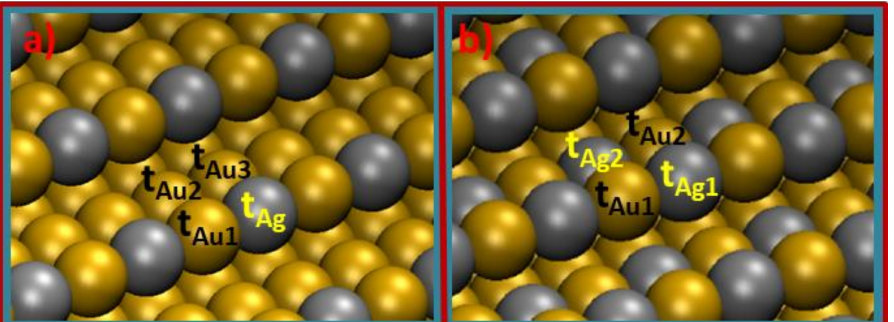
Figure 1. Representation of the Au(210) surface doped with ( a ) one silver atom per unit cell in the step (Ag@Au(210) surface) and ( b ) one silver atom per unit cell in the step and another in the terrace (Ag 2 @Au(210) surface). Top adsorption positions are indicated by t Ag for Ag and t Au for Au atoms, while the adsorption in bridge positions is indicated by b followed of the name used for the atoms forming the bridge in subscripts. Adsorption position in hollow formed by the four atoms shown in both panels of this figure is indicated by h step . Silver atoms are colored in grey, while gold atoms are colored in